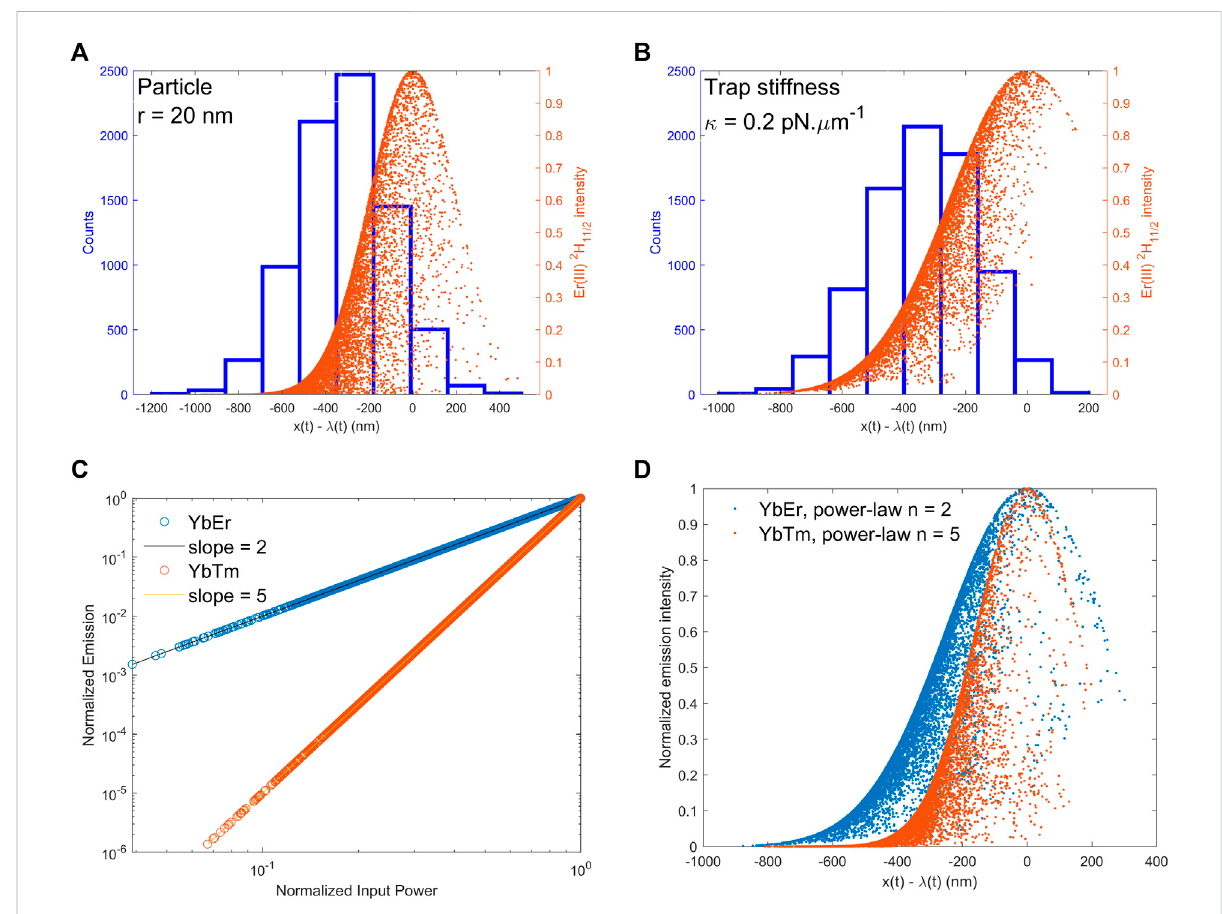
FIGURE 4 Top: Histogram of particle position (in blue) and full set of emission intensities (orange dots) as a function of position: (A) 20 nm radius nanoparticles in dynamic optical trap with υ = 5.5 μ m.s -1 ; (B) 0.20 pN. μ m -1 trap stiffness and υ = 5.5 μ m.s -1 . Bottom: Effect of chemical composition. (C) Nonlinear optical power law for YbEr (blue circles) and Tm (orange circles). (D) Full set ofemission intensities for YbEr (blue dots)and Tm (orange dots) as a function of